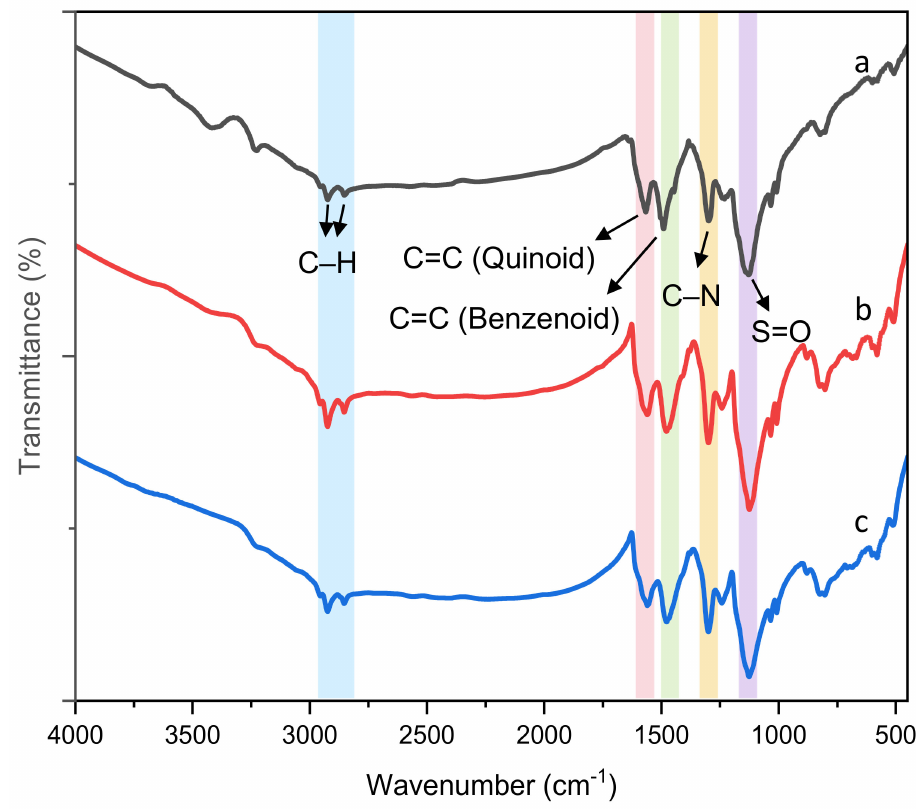
Figure 3. FTIR spectra of pure PANDB ( a ) and conductive PANDB/ γ -Al 2 O 3 core-shell nanocompos- ites synthesized at the weight ratios of AN/ γ -Al 2 O 3 = ( b ) 3/2 and ( c )